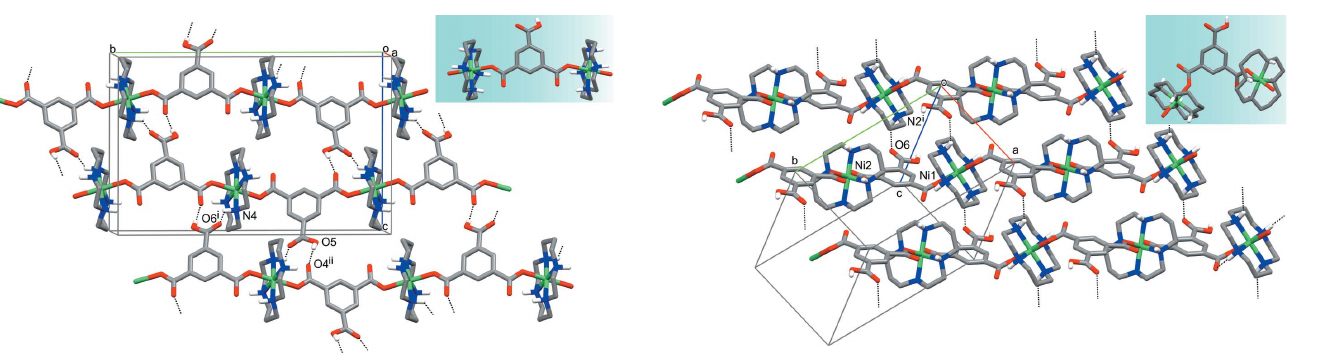
Figure 2 The hydrogen-bonded (dashed lines) sheet in I . C-bound H atoms have been omitted; the intramolecular hydrogen bonds are not shown. The mode of coordination of carboxylate ligand is shown as an inset. Symmetry codes: (i) (cid:3) x + 2, (cid:3) y + 1, (cid:3) z + 2; (ii) x + 1